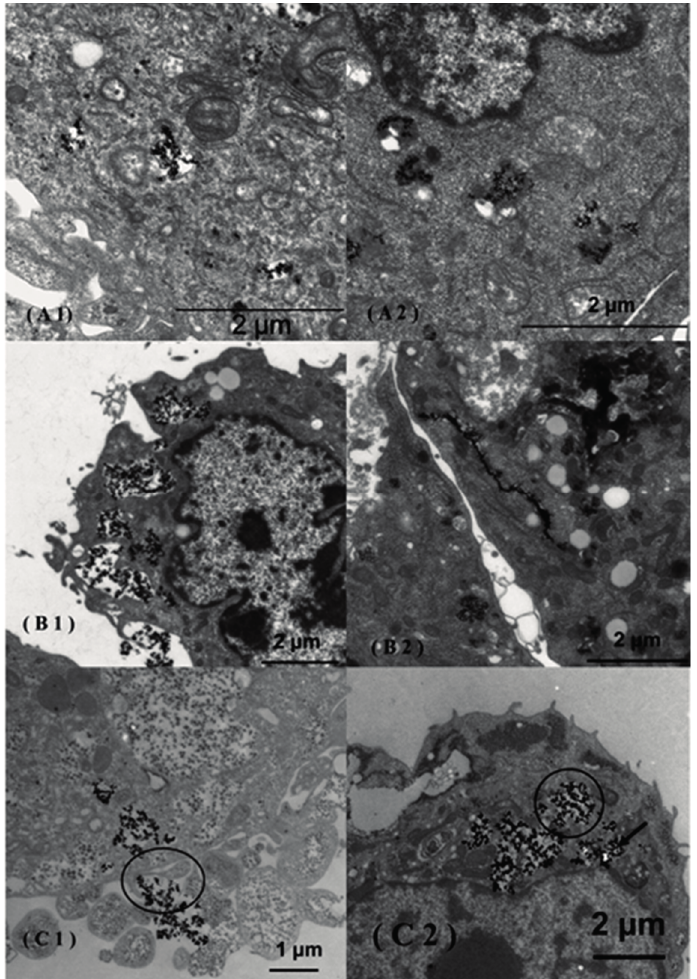
Figure 1. Transmission electron microscopy (TEM) images of MCF-7 ( A1 , A2 ), 3T3 ( B1 , B2 ) and Caco-2 ( C1 , C2 ) cells incubated in the presence of